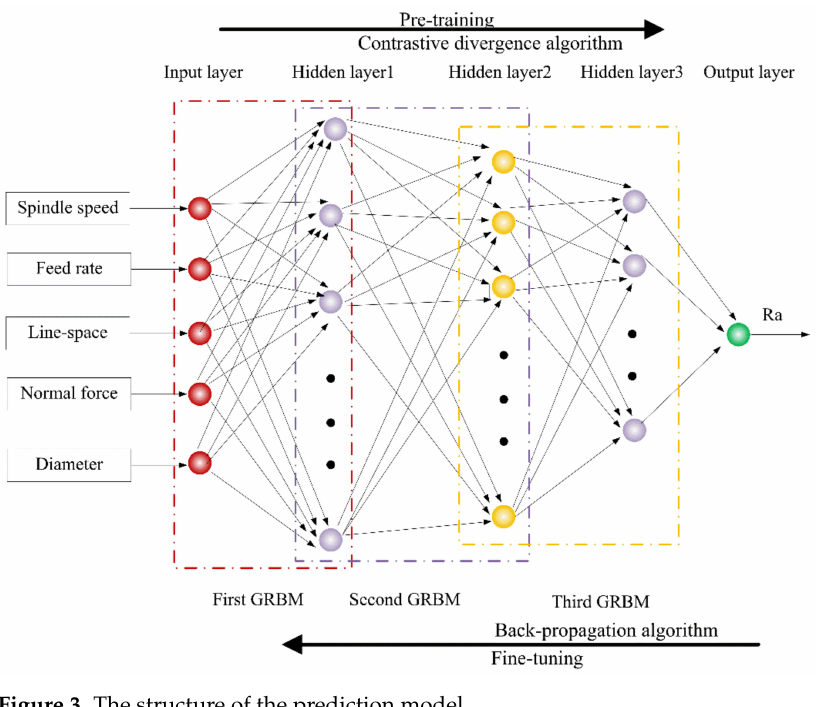
Figure 3. The structure of the prediction model.